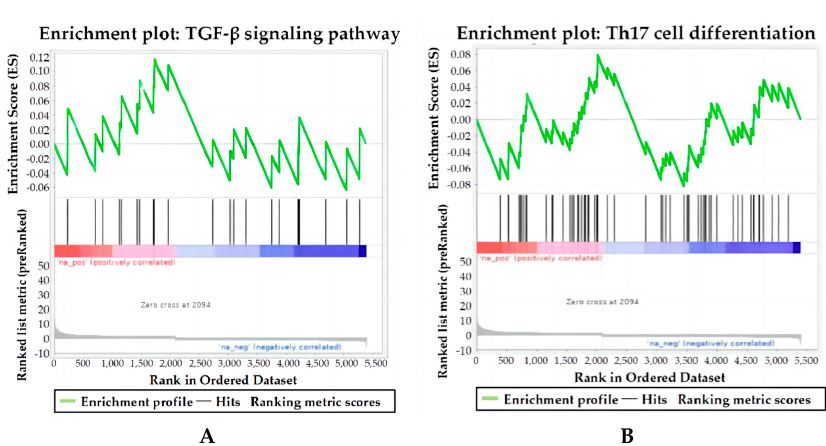
Figure 4. Pathway enrichment map of TGF- β signaling pathway and Th17 cell differentiation by GSEA. The graph is divided into three parts, the first part is the line graph of the protein enrichment